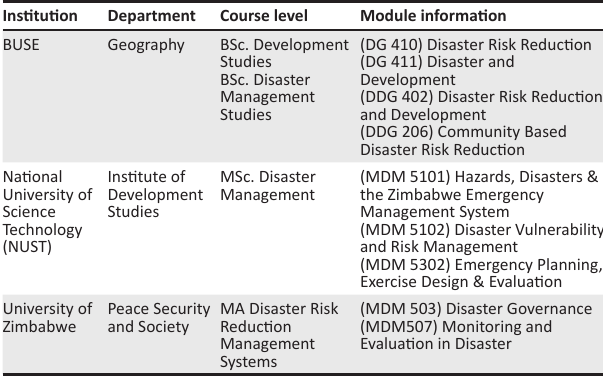
TABLE 1: Disaster risk management